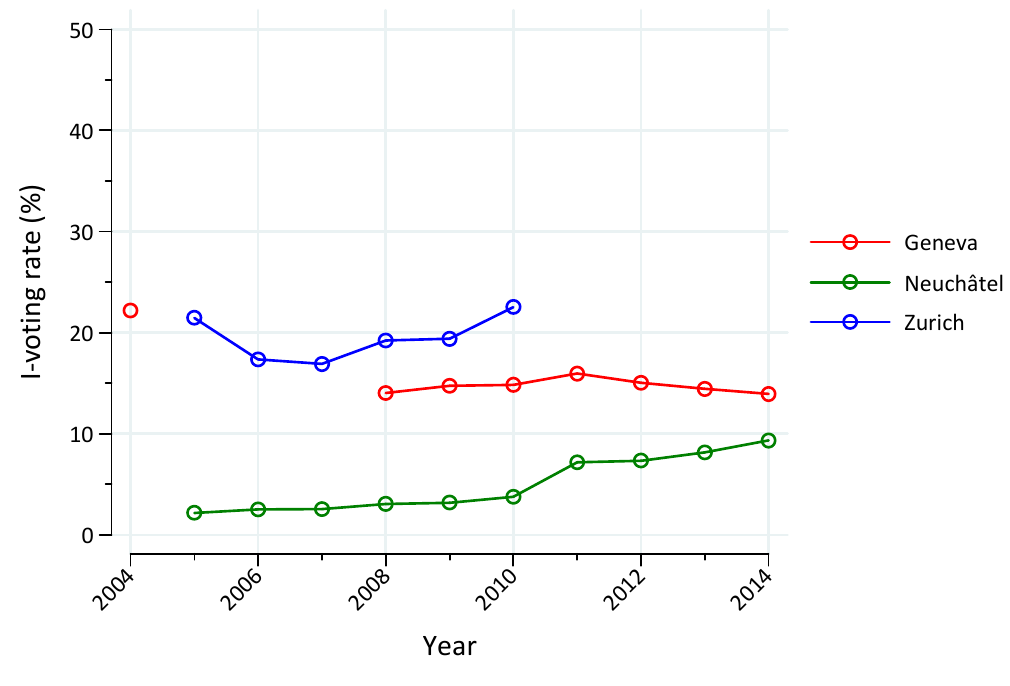
Figure 3: Popularity of the online channel among residential